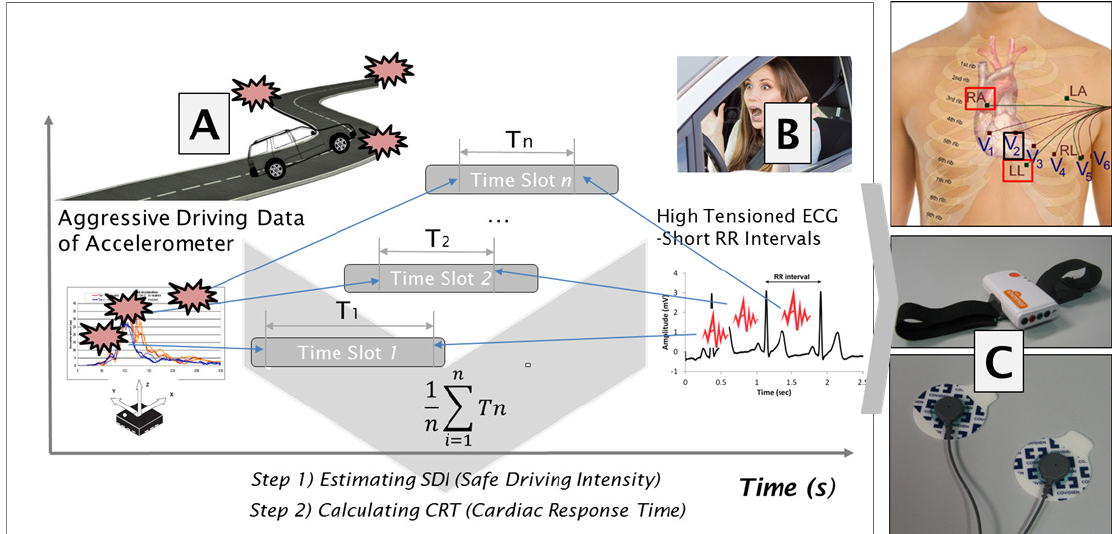
Figure 1. Illustration of the SDI and CRT, which are correlated interactions between ( A ) and ( B ). It is an important measure to evaluate safe driving ability. The portable Shimmer3 EEG unit(Shimmer, Dublin, Ireland) was used to monitor the ECG signal while driving ( C